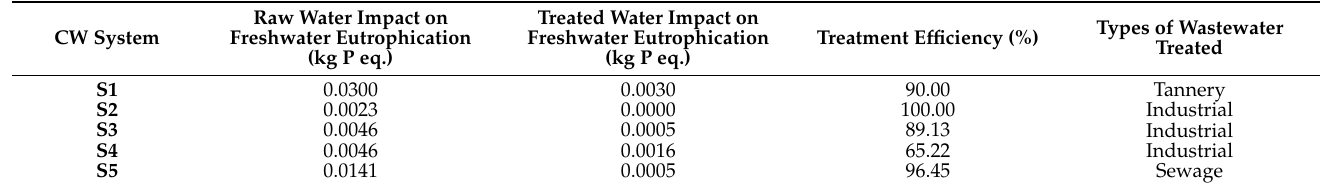
Table 3. Comparative aquatic eutrophication impact from raw and treated wastewater of the different constructed wetland systems and treatment